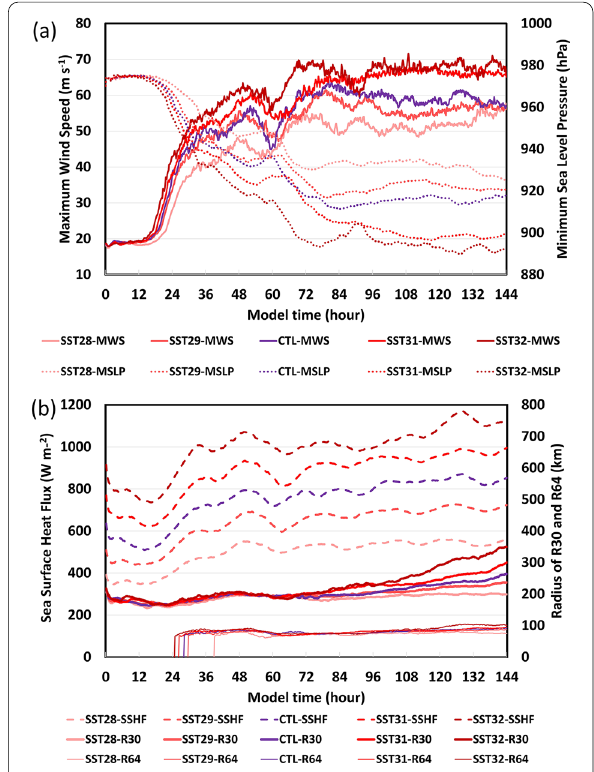
Fig. 4 a MSLP (dotted lines) and MWS (solid lines). b SSHF (long dashed lines), R30 (thick lines), and R64 (thin lines) of S‑SST sensitivity